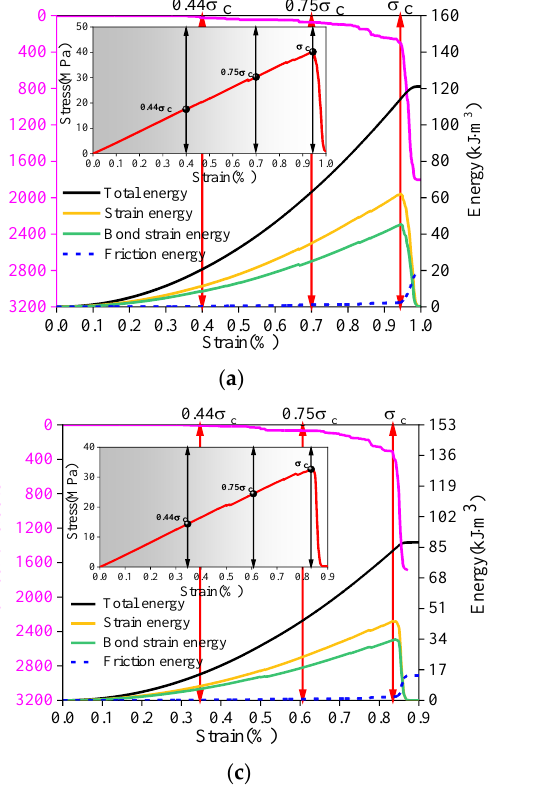
Figure 10. The evolution of different types of energy in different F-T cycles: ( a ) 0 cycle; ( b ) 10 cycle; ( c ) 20 cycle; and ( d ) 30 cycle. In order to explore the intrinsic relationship between the number of freeze-thaw cy- cles and different types of energy, the energy values of different stages were fitted to the F-T cycle. The fitting results are shown in Figure 11. The results showed that when the value points are 0.44σ c and 0.75σ c , the total energy, strain energy, bond strain energy, and friction energy have a good exponential relationship with the freeze-thaw cycles, the fit- ting coefficients of which are above 0.94. With the gradual increase in the number of freeze-thaw cycles, the total energy, strain energy, bond strain energy, and friction energy all showed an exponentially decreasing trend. At the point of peak strength (σ c ), the num- ber of freeze-thaw cycles was exponentially related to the total energy and strain energy, and the fitting coefficient was 0.81964~0.86064. However, the bond strain energy and fric- tion energy conformed severally to a good exponential relationship with freeze-thaw cy- cles, for which the fitting coefficient was above 0.95. While the number of freeze-thaw cycles gradually increased, the total energy, strain energy, bond strain energy, and friction energy all showed the law of exponential decrease.